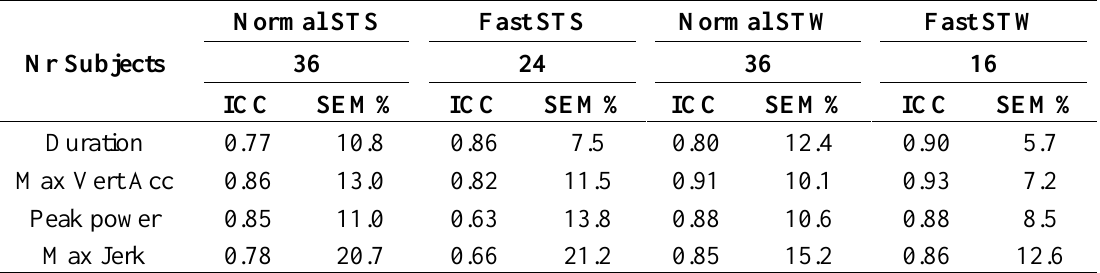
Table 2. Summary of evaluations of the relative and the absolute reliability in chair rise measurements in individual